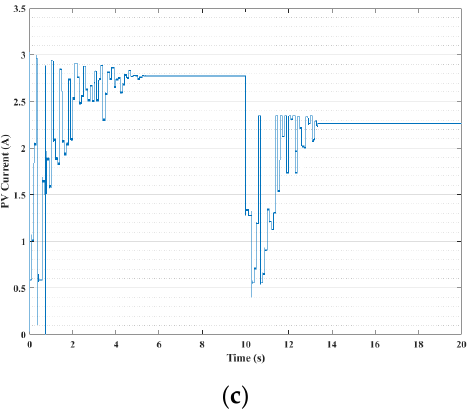
Figure 16. Modified LFO at STC to PSC1. ( a ) power ( b ) voltage ( c ) current.